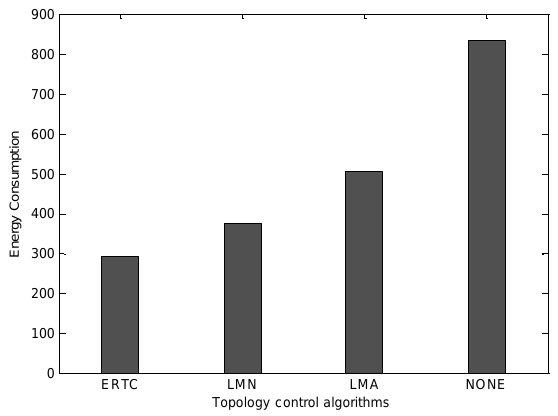
Figure 13. The energy consumption of different topology control protocols.